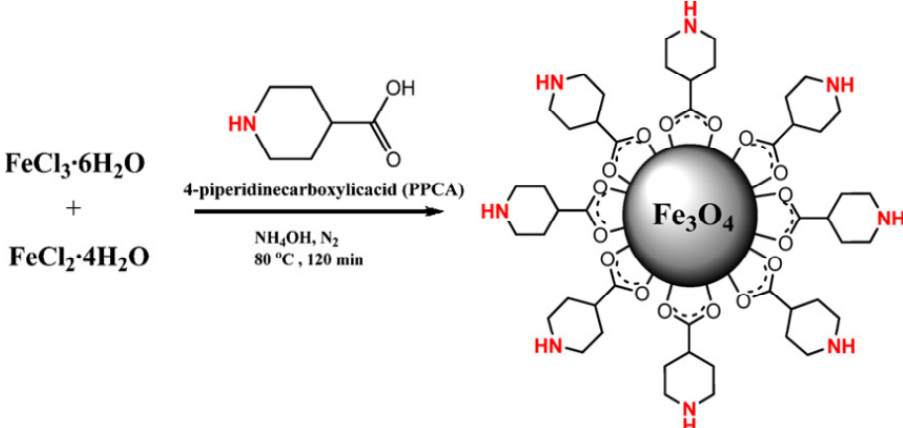
Figure 9. Synthesis of piperidine carboxylic acid stabilised magnetite